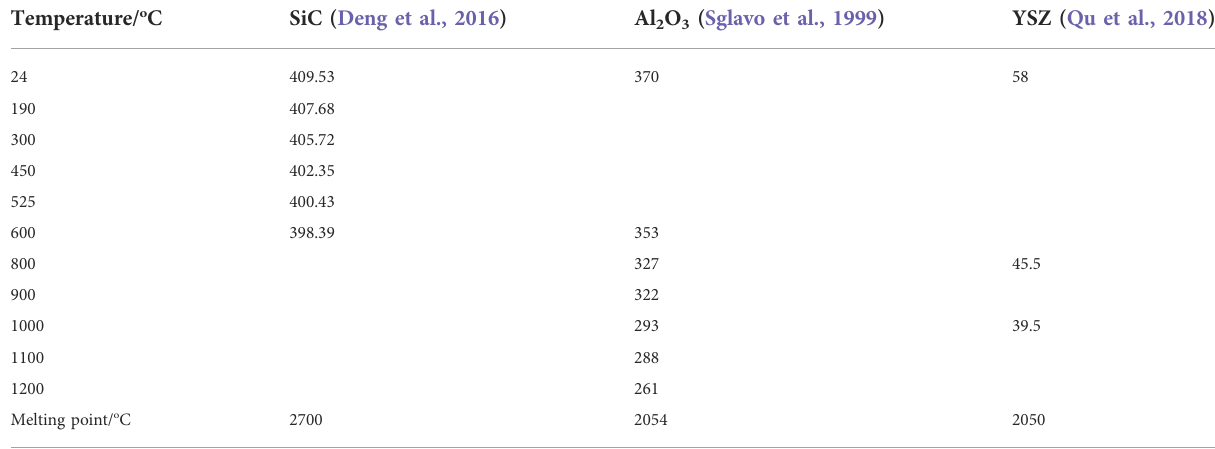
TABLE 1 Temperature-dependent Young ’ s modulus and melting point (Sglavo et al., 1999; Deng et al., 2016; Qu et al., 2018). Temperature/ o